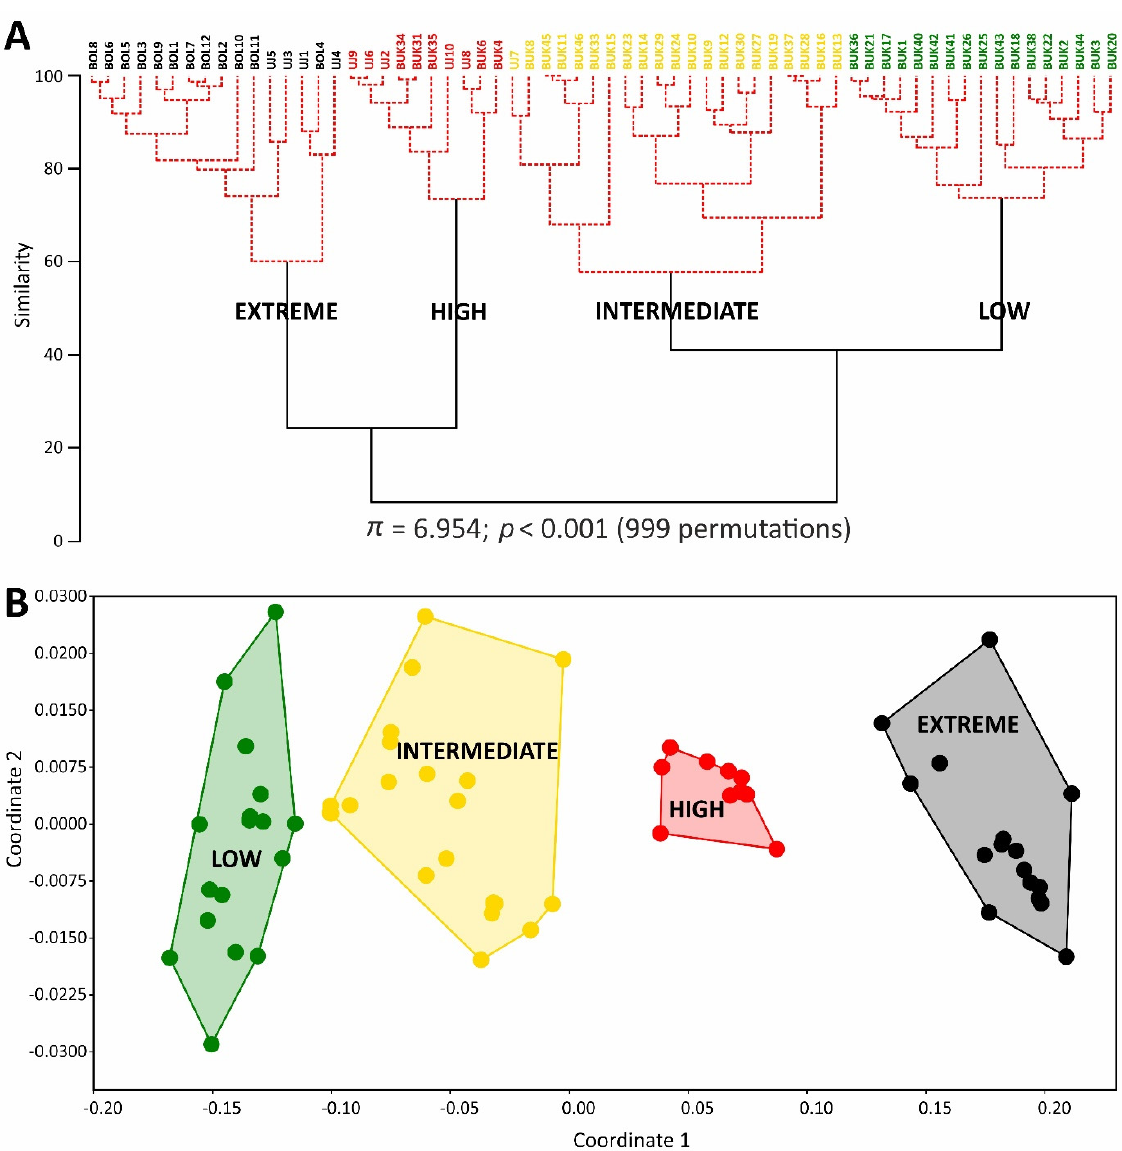
Figure 1. Cluster analysis dendrogram ( A ) and non-metric multidimensional scaling (NMDS) scat- terplot ( B ) of study plots assigned to four soil condition classes. The black lines in the dendrogram indicate groups that are established; red lines show a sub-structure from the clustering for which there is no statistical support from the SIMPROF test. Convex hulls on the NMDS scatterplot encompass particular soil condition classes.